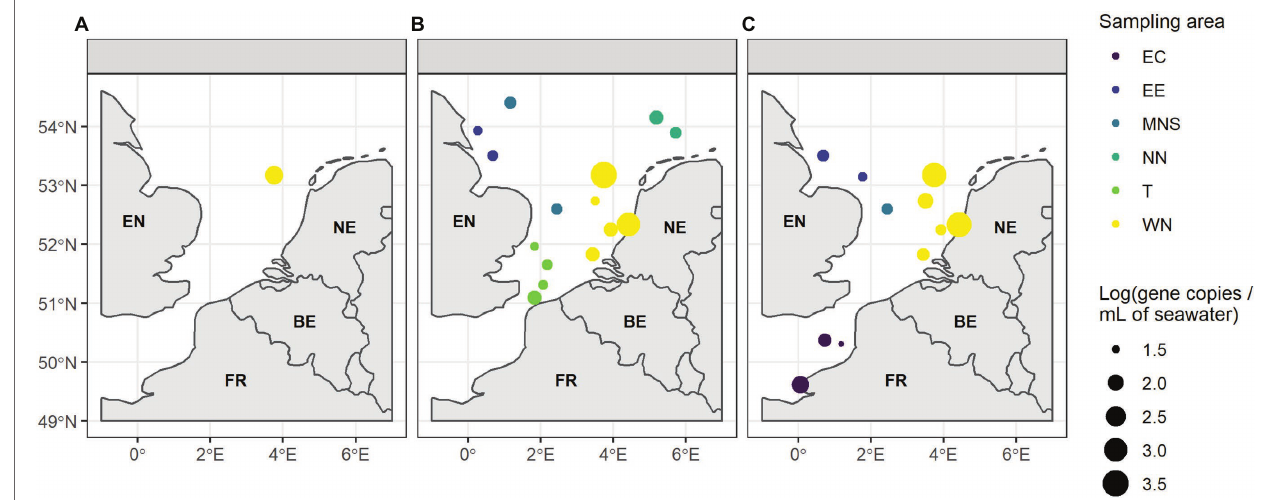
FIGURE 2 | Absolute abundance of the three (A) tetA ; (B) sul1 , and (C) intI1 indicator genes (gene copies.ml -1 of seawater, log-transformed) in the six areas. EC, East English Channel; EE, East England coast; MNS, Middle of the North Sea; NN, North Netherlands coast; T, Thames mouth; and WN, West Netherlands coast. EN, England; NE, Netherlands; FR, France; and BE, Belgium. The samples with no quantification of genes are not